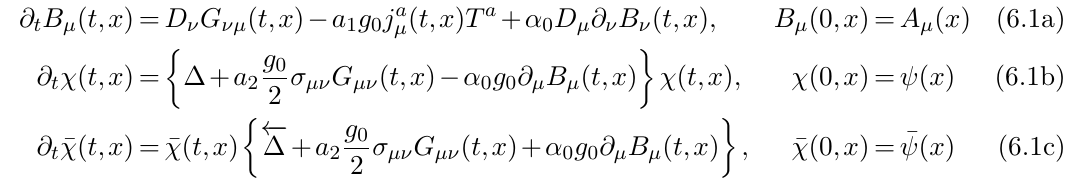
Figure 9. Relative change for the different h E i when N f is increased by 1, see (5.4). Differences decrease for smaller values of t Λ 2 qualitative structure remains the